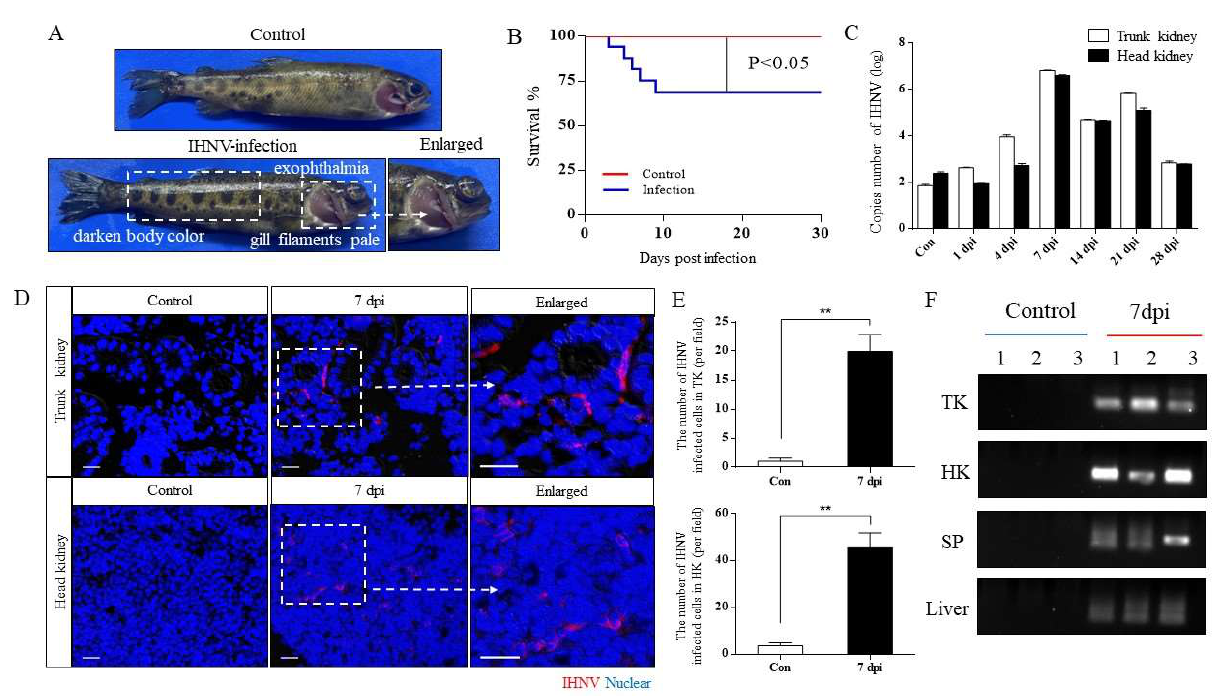
Figure 1. Successful construction of IHNV infection model of rainbow trout. ( A ) The phenotype of rainbow trout after IHNV infection. The top and bottom were the control and infected groups, respectively. ( B ) The survival rate of rainbow trout after IHNV infection. ( C ) The copy number of IHNV in the head and trunk kidney was detected in the control and infected rainbow trout at 1, 4, 7, 14, 21, and 28 dpi ( n = 6 fish per group). ( D ) Histological examination of IHNV signal in the head and trunk kidney of the control and infected group at 7 dpi, with merged immunofluorescence staining with IHNV (red) and nuclei (blue). Scale bar, 20 µ m. ( E ) Statistical results of immunofluorescence IHNV signal ( n = 6 fish per group). ( F ) IHNV load of trunk kidney (TK), head kidney (HK), spleen (SP), and liver at 7 dpi were detected by PCR. ** p < 0.01 (unpaired Student’s t test).